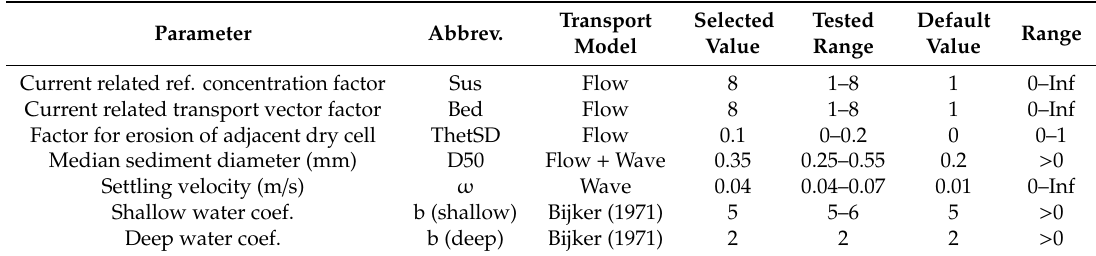
Table 5. Sediment transport module (Delft3D-SED)